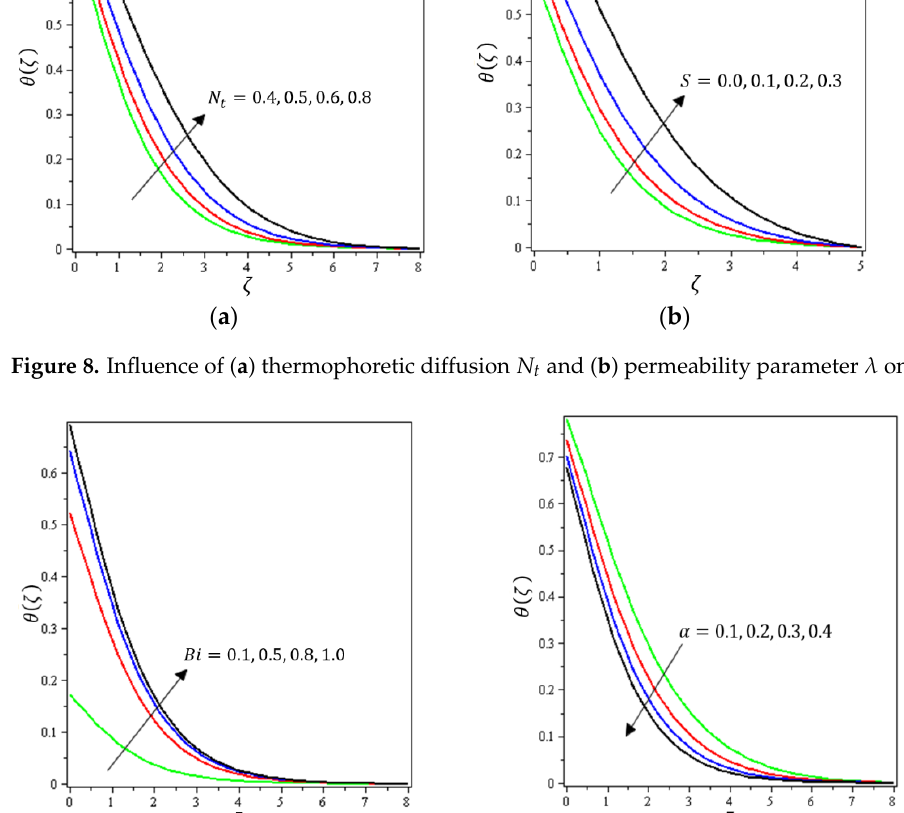
Figure 9. Influence of ( a ) Biot number 𝐵𝑖 and ( b ) material parameter 𝛼 on 𝜃(𝜁) .